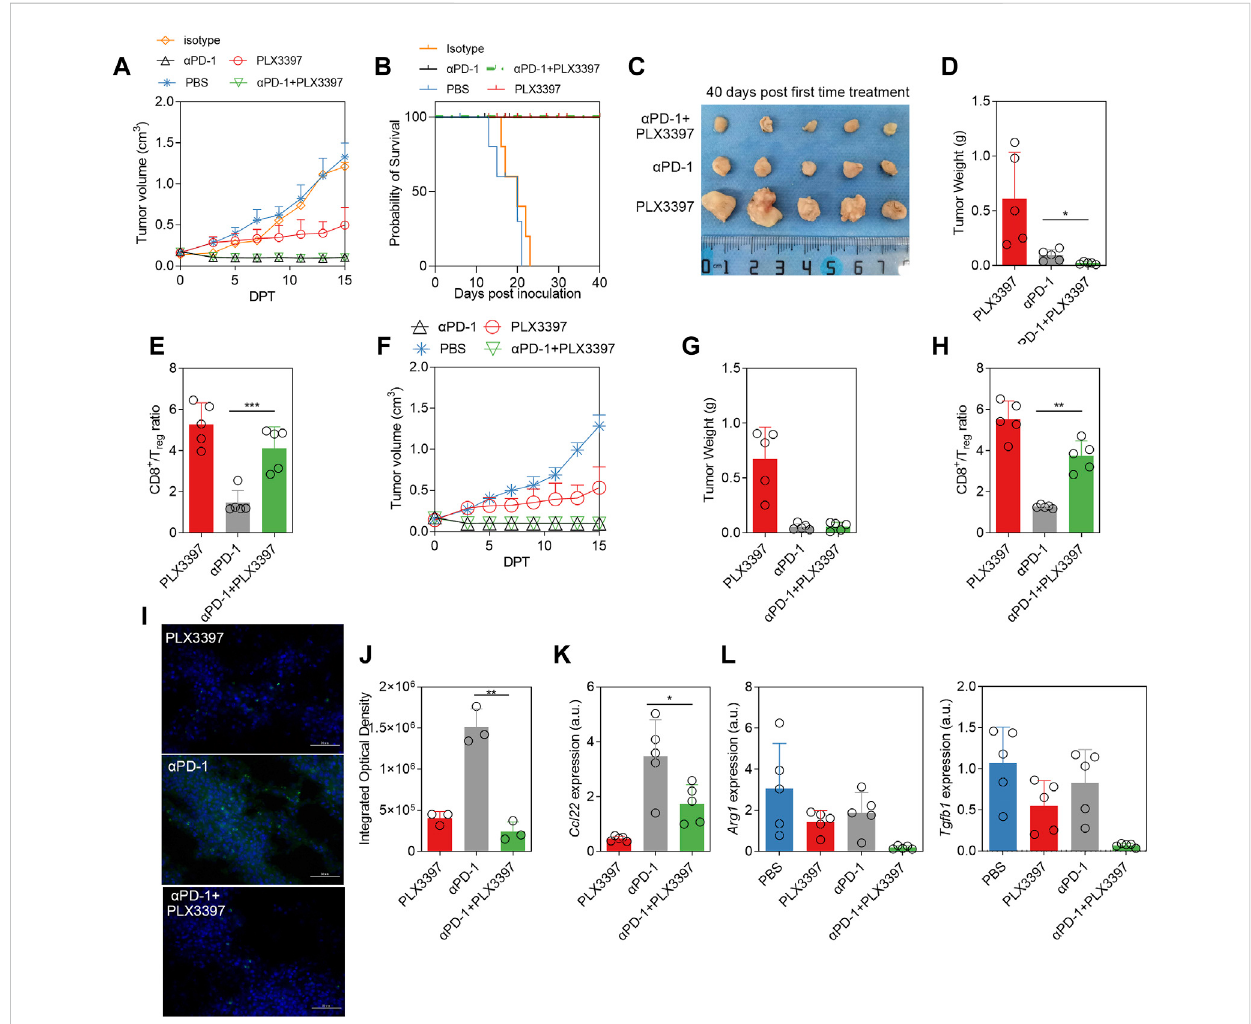
conducted according to thedescriptionin themethod; (B) Survival rate ofdifferenttreatmentgroups after PLX3397 combined with α PD-1, n = 5; (C) The miceweresacri fi cedon40 daysafter treatment began,thesubcutaneoustumorswerecollected,photographedand (D) thetumorswereweighed; (E) The proportion of CD8 + T cells/Treg cells was analyzed by fl ow cytometry at day 40 after treatment began; (F) One of two independent α PD-1 treatmentexperiments, n =5, (G) thetumorsof40DPTwereweighedand (H) Theproportion ofCD8 + Tcells/Tregcellswasanalyzedby fl owcytometry. (I) Representative fi gureofFISHwasusedtoidentify Ccl22 transcriptionintumorand (J) integratedopticaldensitystatisticalresults. (K) qPCRwasusedto analyze the transcription of Ccl22 in puri fi ed tumor macrophages on day 40 after treatment. (L) The transcriptional levels of Arg 1 and Tgfb1 in